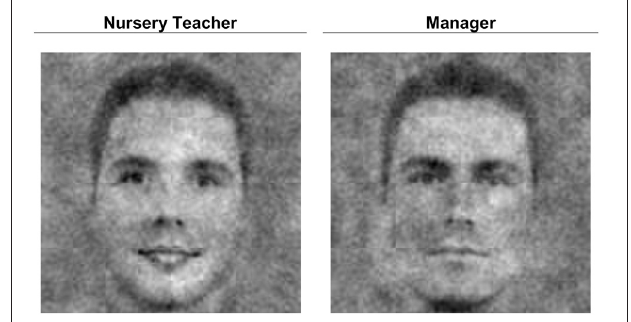
FIGURE 2 | Classification images for nursery teacher and manager based on responses of N = 92 ( n = 46 per